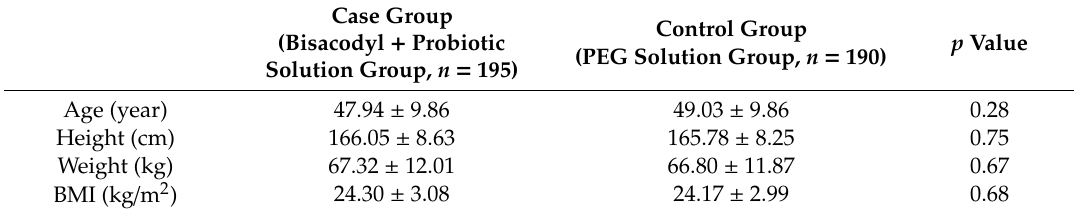
Table 1. Patient